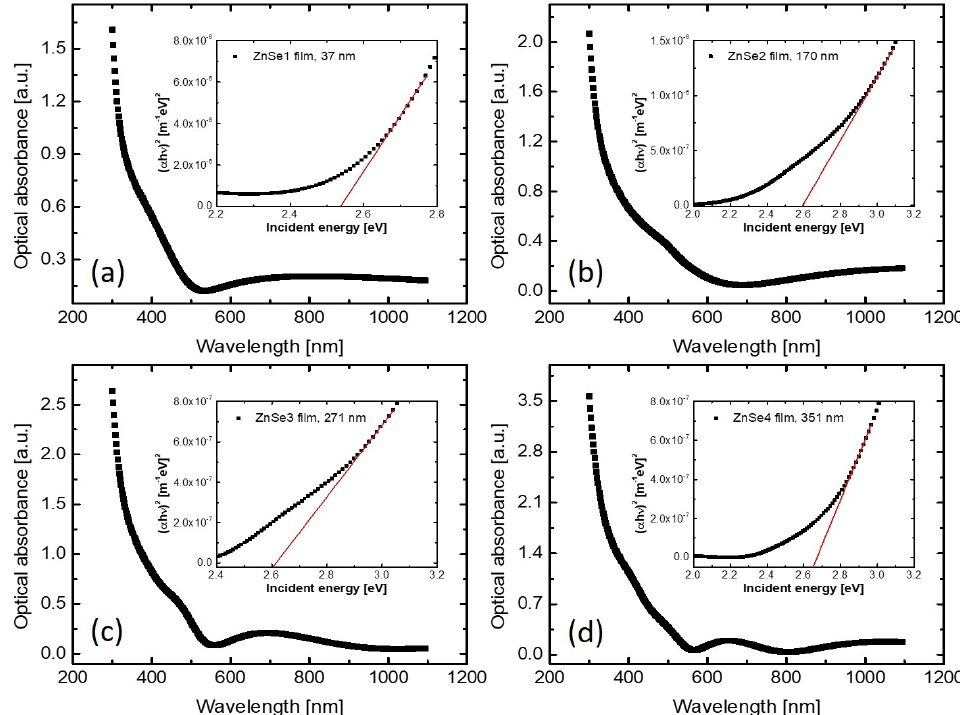
Figure 7. Spectral dependencies of optical absorbance for samples ZnSe1 ( a ), ZnSe2 ( b ), ZnSe3 ( c ), and ZnSe4 ( d ). The inset of graphs shows the ( α ¯ h ω ) 2 vs. ¯ h ω dependencies (Tauc’s plots), used to determine the optical band gap energies ( E g ) of the ( OS )